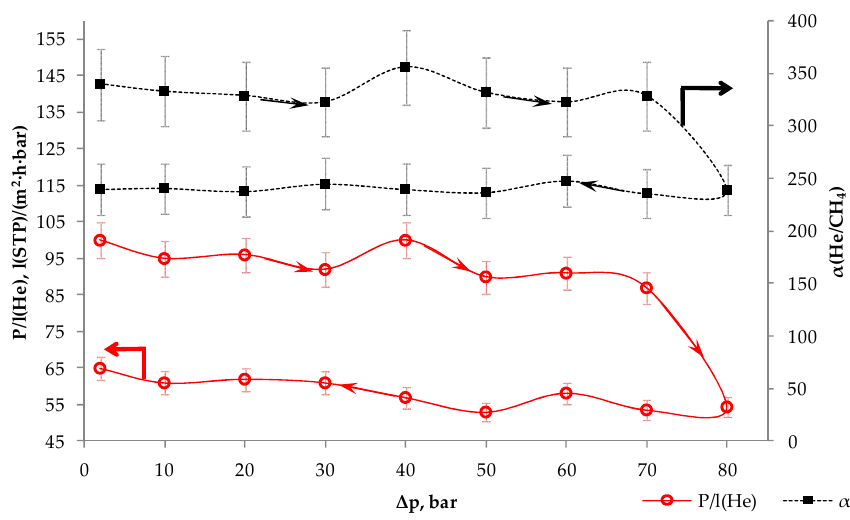
Figure 6. The influence of transmembrane pressure on helium permeance (P/l(He)) and selectivity ( α (He/CH 4 )) during pressurization and depressurization. The sequence of the experiment is shown by the arrows; lines were drawn to guide the eye.